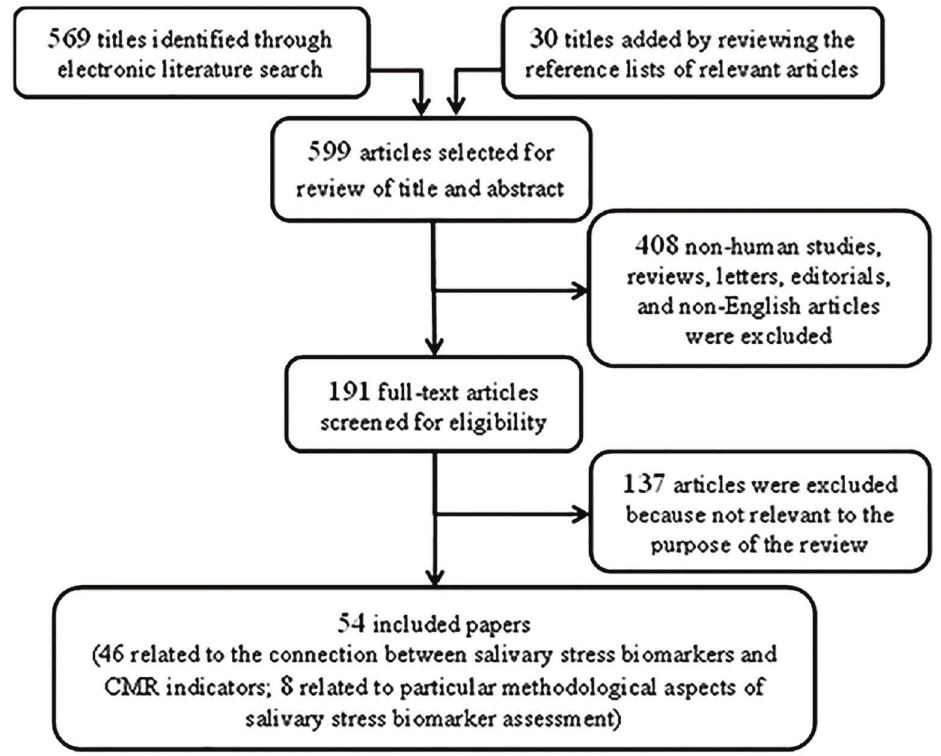
Figure 1. Literature selection